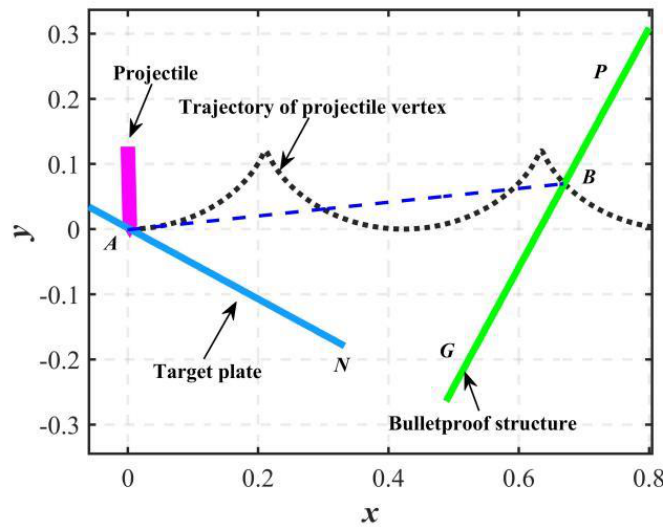
Figure 12. Graphical analysis of the ricocheting projectile and its deflection angle. The coordinate of impacting point B is (0.67, 0.07); thus, the deflection angle ( ∠ NAB) is 34.66 ◦ , which is the sum of β and the angle between line AB and the X axis, with an arc tangent of 0.07/0.67. Compared with the experimental results, the prediction error of the deflection angle is no larger than